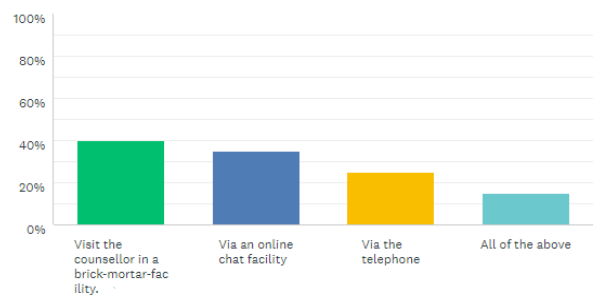
Figure 4. Respondent’s preferred counselling